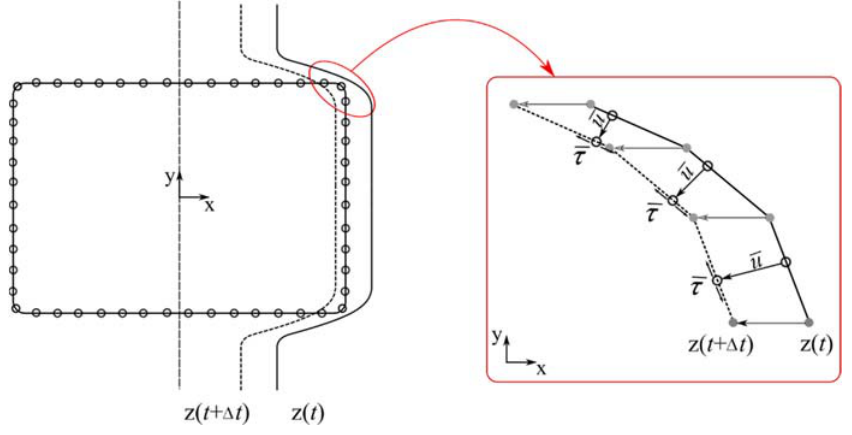
Figure 4. Boundary nodes during contact with groove surface and applied boundary conditions. Interpolating an unknown field with regular node distribution over a rectangular